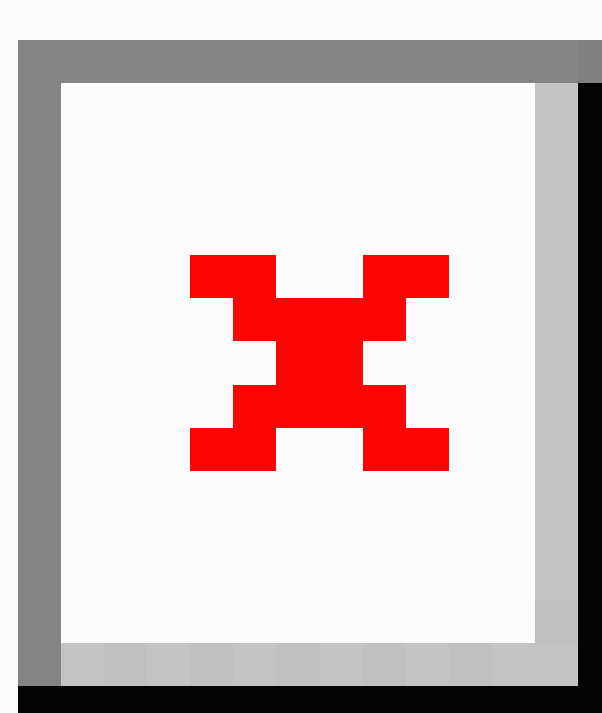
No significant differences were observed between age and body mass index (BMI) for males and females. Participants who completed the WFR (validation study) were, on average, 4.6 years younger than the participant group as a